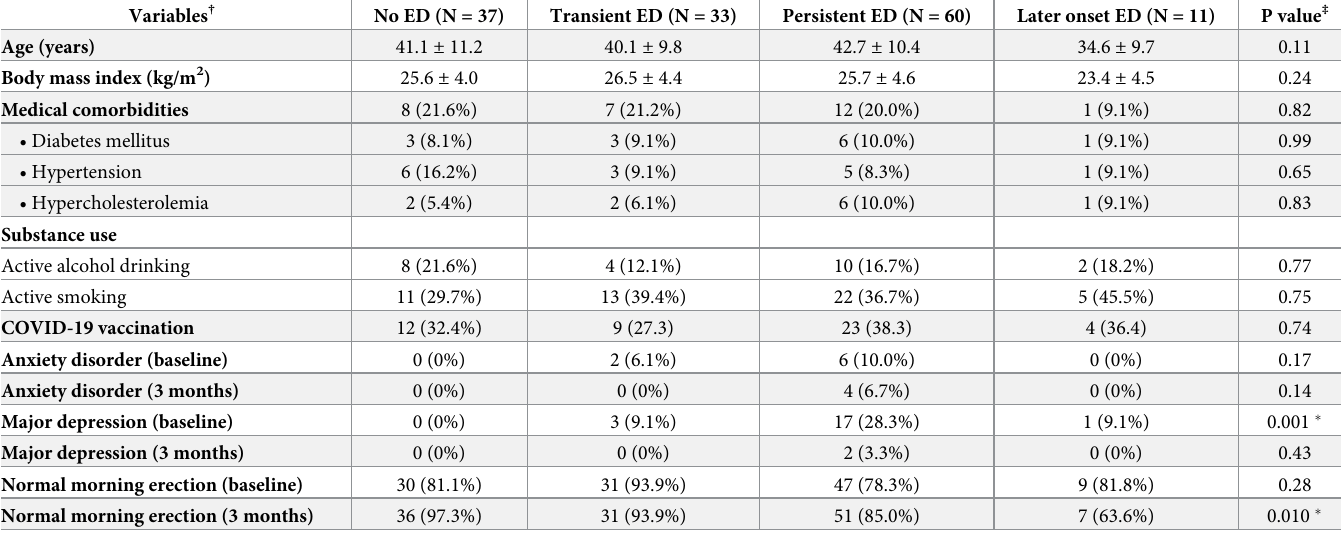
Table 4. Demographic data and associated factors among four groups of erectile dysfunction.